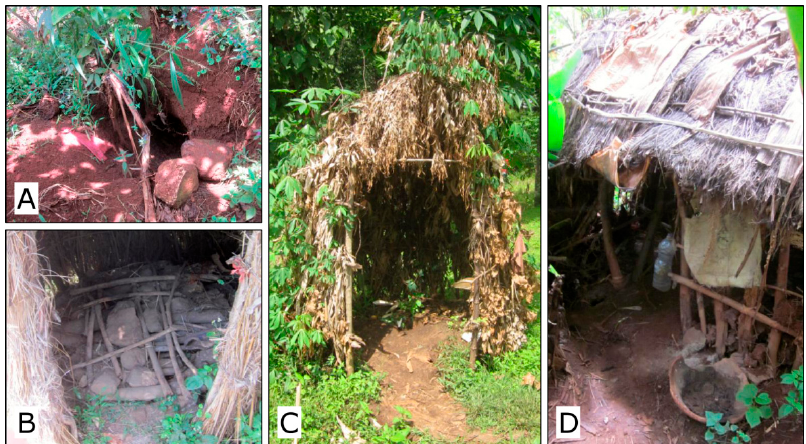
Figure 3. Examples of surveyed sanitation facilities: ( A )—Unimproved pit, no other facilities; ( B )—Simple slab platform, squatting hole covered; ( C )—Pit latrine with solid slab, basic superstructure, apparent footpath; ( D )—Pit latrine with solid slab, superstructure ensuring privacy, water and ash available for handwashing.